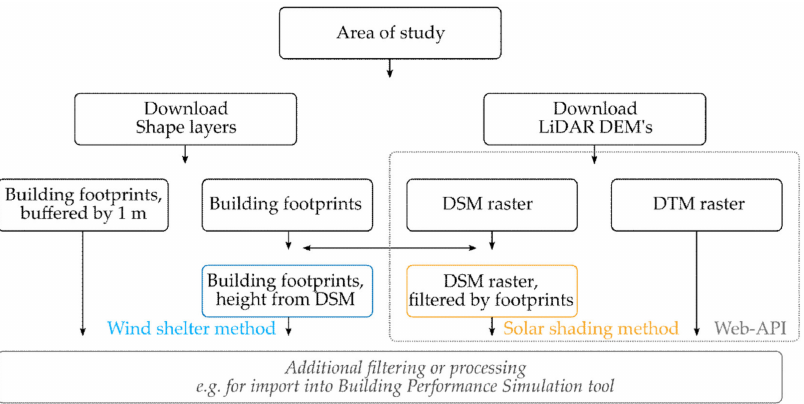
Figure 1. Proposed workflow to assess local sheltering using the wind shadow method and the solar shading model in Section